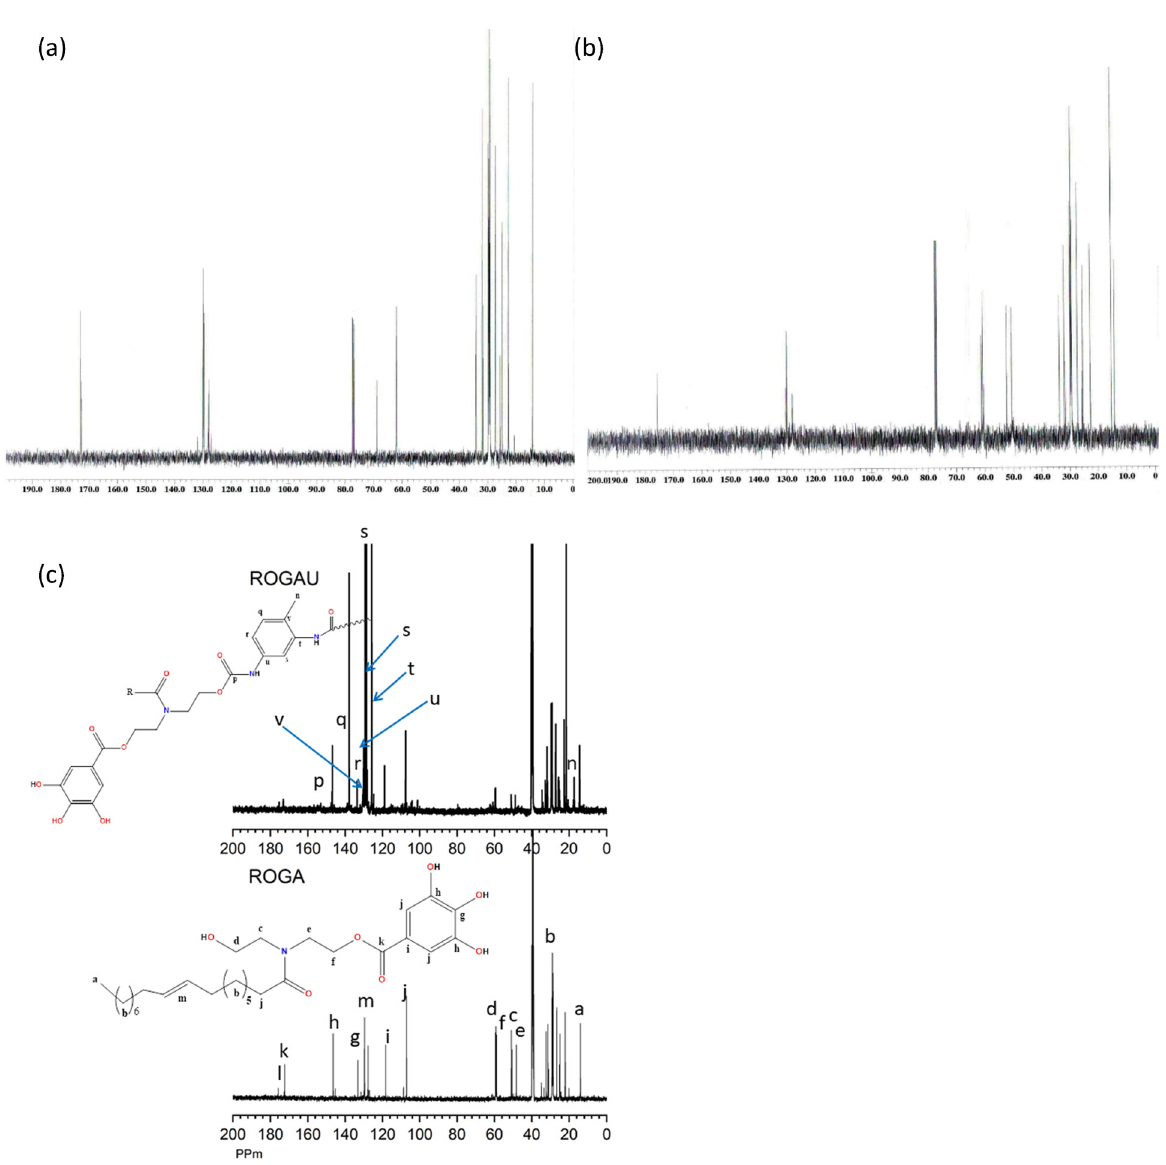
Figure 3: 13 C NMR spectra of ( a ) RO, ( b ) HERA, ( c ) ROGA and ROGAU.